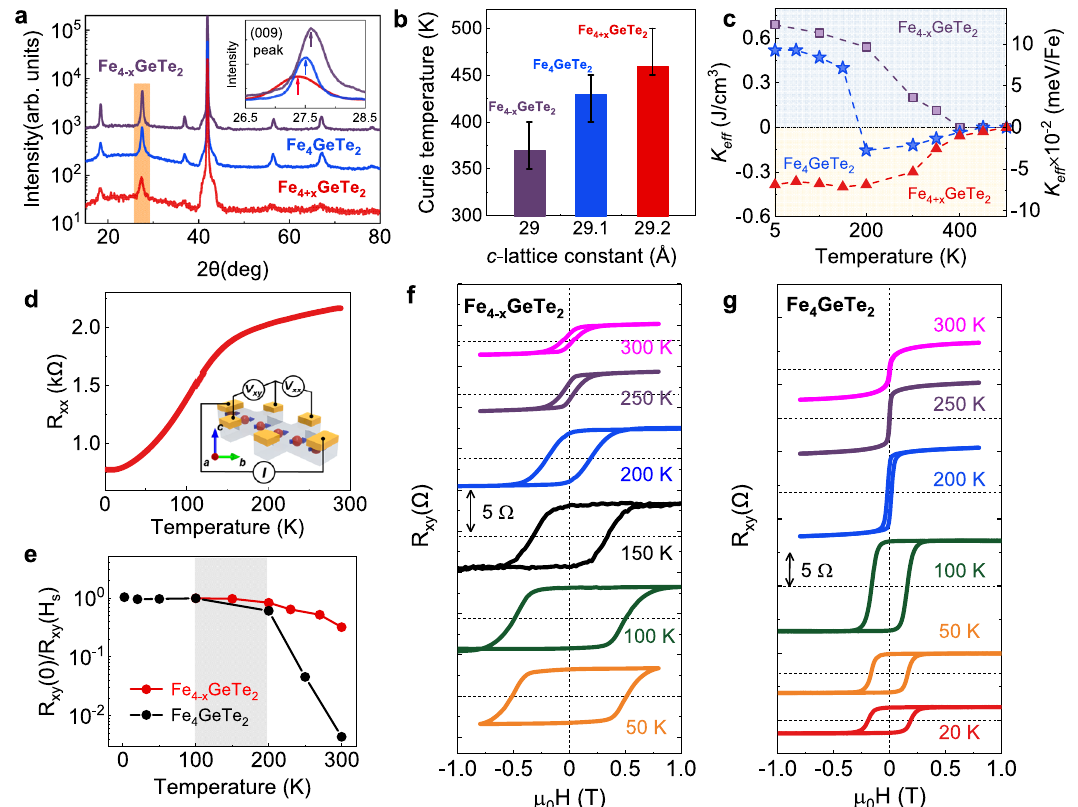
Fig. 3 | Doping-modulated magnetism in Fe 4 GeTe 2 . a XRD scan of the samples with different Fe doping concentrations, which all belong to vdW Fe 4 GeTe 2 struc- turewithoutanyphasedisorders.Inset:the(009)peaksofthesamples,re fl ectinga slight shift of the XRD curves under different Fe concentrations. b The c -lattice constants and T c of all the samples, both parameters have a positive correlation with the Fe concentration. The error bars describe the deviation in calculated T c between Arrott plots and mean- fi eld fi tting (Fig. S11). c Effective magnetic